Question: Draft a figure caption describing what is shown.
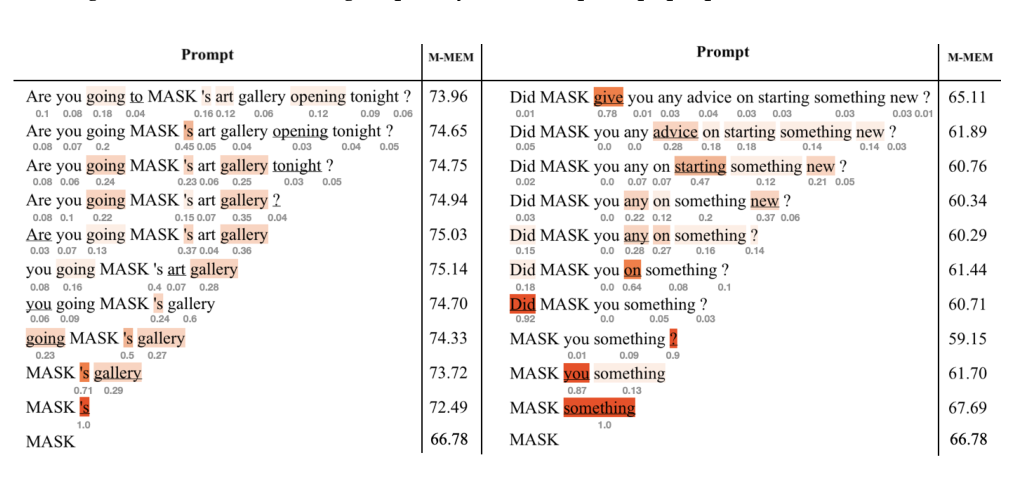
Answer: Analysis of the token importance in prompts and the M-MEM scores for the BERT-B model. The best-performing (left) and the worst-performing (right) prompts were selected on the dev set. The heatmaps are generated with leave-one-token-out: at each step, the least important token is removed from the best-performing prompt, and the most important token is removed from the worst-performing prompt. The normalized token importance scores are under the corresponding tokens. The removed tokens are underlined.